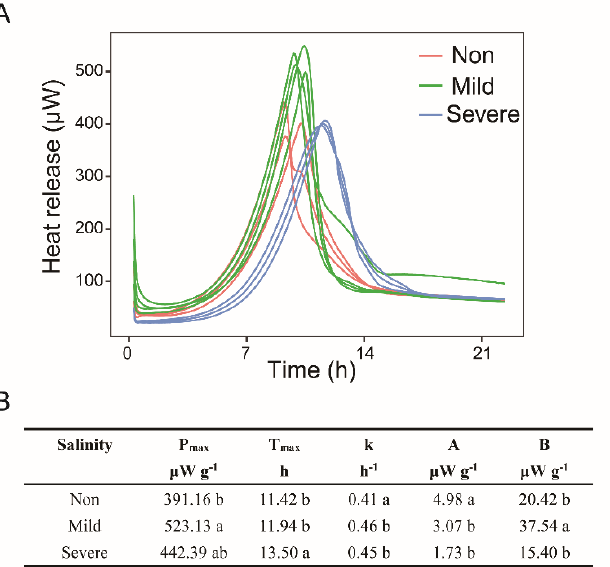
Figure 8. Substrate induced heat release curves ( A ) and microbial characteristics of growth response with three salinity levels ( B ): Non–salinity, Mild–salinity and Severe–salinity. Different letters above bars denote significant differences ( p < 0.05) among salinity levels. P max , the maximum heat flow rate; T max , the peak power time; k, the specific growth rate of the soil microbial community; A, the initial heat flow rate uncoupled from cell growth; B, the initial heat flow rate of the growing fraction coupled with cell growth.